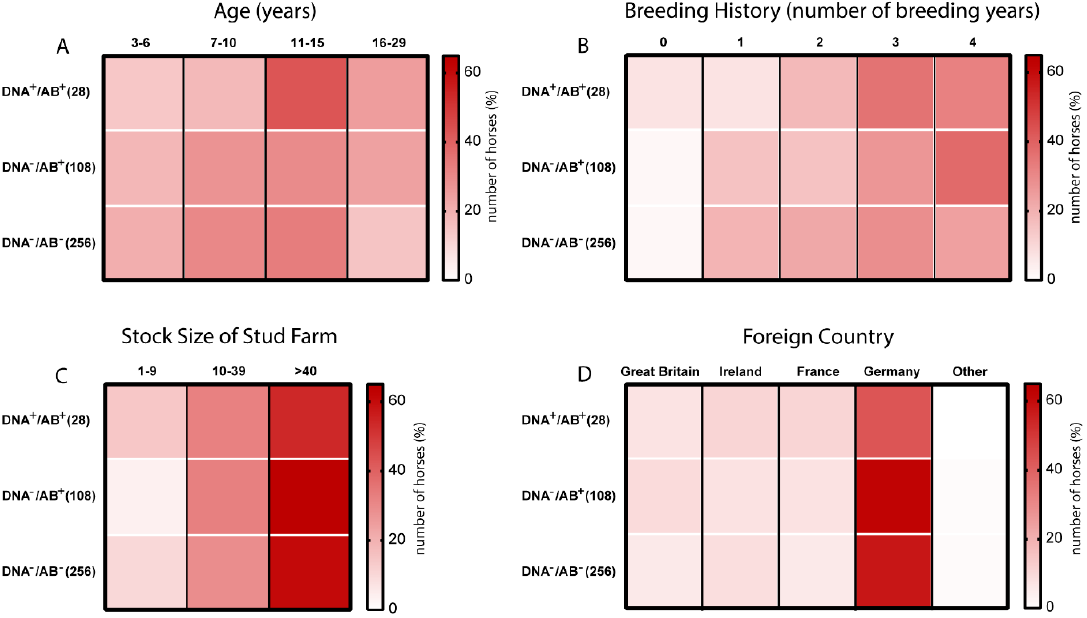
Figure 3. Heatmaps displaying the occurrence of anti-EqPV-H VP1 AB and EqPV-H DNA with regard to potential risk factors. The three groups based on the EqPV-H infection status were further classified based on ( A ) age, ( B ) breeding history, ( C ) stock size of the stud farm, and ( D ) foreign country. The colouring indicates the number of horses (in %) classified in the specific category. Each row adds up to 100%.